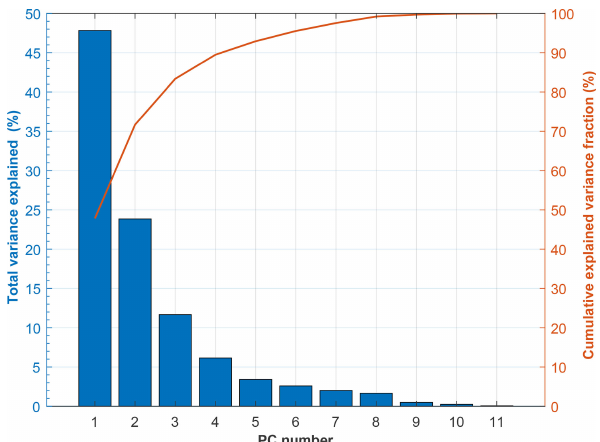
Figure C1. Fraction of variance explained by each PC (left hand or- dinate), listed in Table C1, and cumulative explained variance (right hand ordinate). PCA was performed on a subset of 10000 particles, randomly selected from the entire calibration data set and consisting of equal numbers of spherical and aspherical